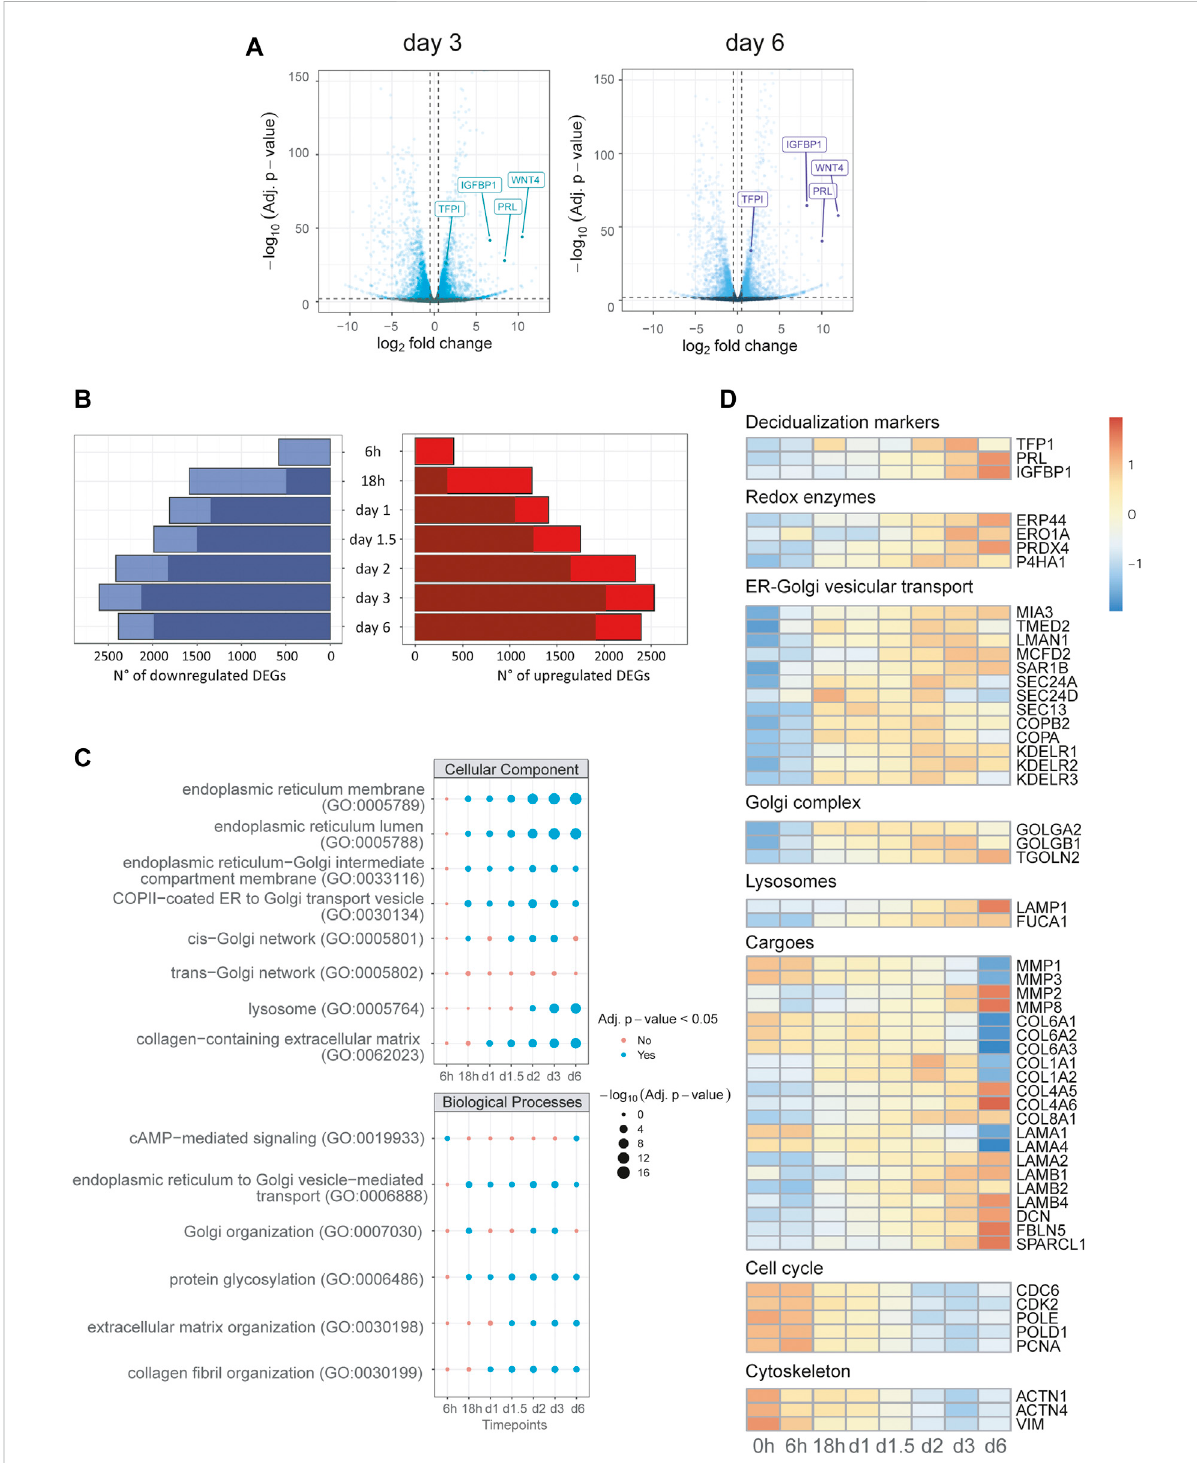
FIGURE 2 Transcriptional reprogramming of the secretory compartment is an early event in decidualization. Differential expression analysis and Over- RepresentationAnalysis(ORA)oftimecoursebulkRNA-seq. (A) Volcanoplotsofday3and6,genelabellingfordecidualizationmarkers(PRL,IGFBP1, TFP1), which act as positive controls for our experimental set up. (B) Number of DEGs called for each timepoint grouped for upregulation or downregulation:foreachbar,thedarkershadesofcolourrepresentthenumberofgenescalledDEGsalsoattheprevioustimepoint. (C) ORAof upregulated DEGs for GO terms for each timepoint: early enrichment is observed for pathways related to the compartments and biological processesofthesecretorypathway. (D) HeatmapofrepresentativeDEGsforcanonicalbiologicalfunctions involvedindecidualizationuptoday6of differentiation. Note the upregulation of genes of the early secretory pathway and the downregulation of genes correlated with cell cycle and DNA repair. The rearrangements of cargos (collagens, laminins) is already evident just a few hours after stimulation.